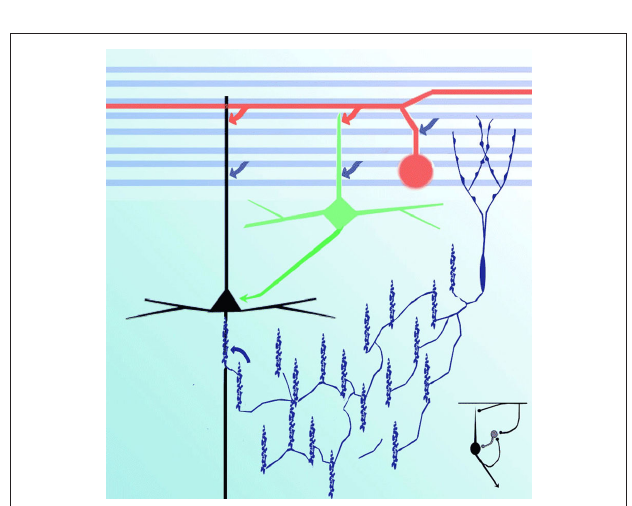
Figure 7 | Seventy-six-micrograph photomontage of the proximal axon of an interfascicular neuron. The axon (arrow) divides dichotomously (hollow arrows), and daughter fibrils proceed in opposite directions. Rapid-Golgi technique, adult mouse brain. Scale bar = 10 μm.